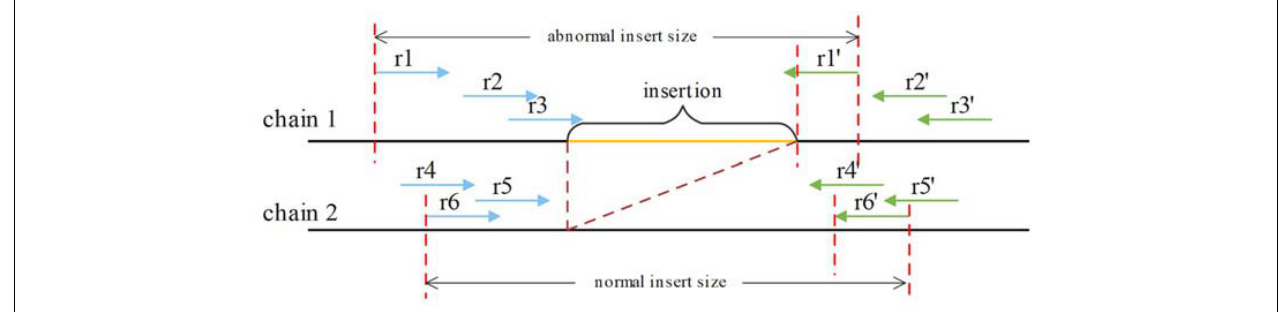
FIGURE 4 | The paired reads (r1, r1 (cid:48) ), (r2, r2 (cid:48) ), and (r3, r3 (cid:48) ) are obtained on the first chain, which contains an insertion. The other paired reads were obtained on the normal chain as shown. These insert sizes can be clustered into two